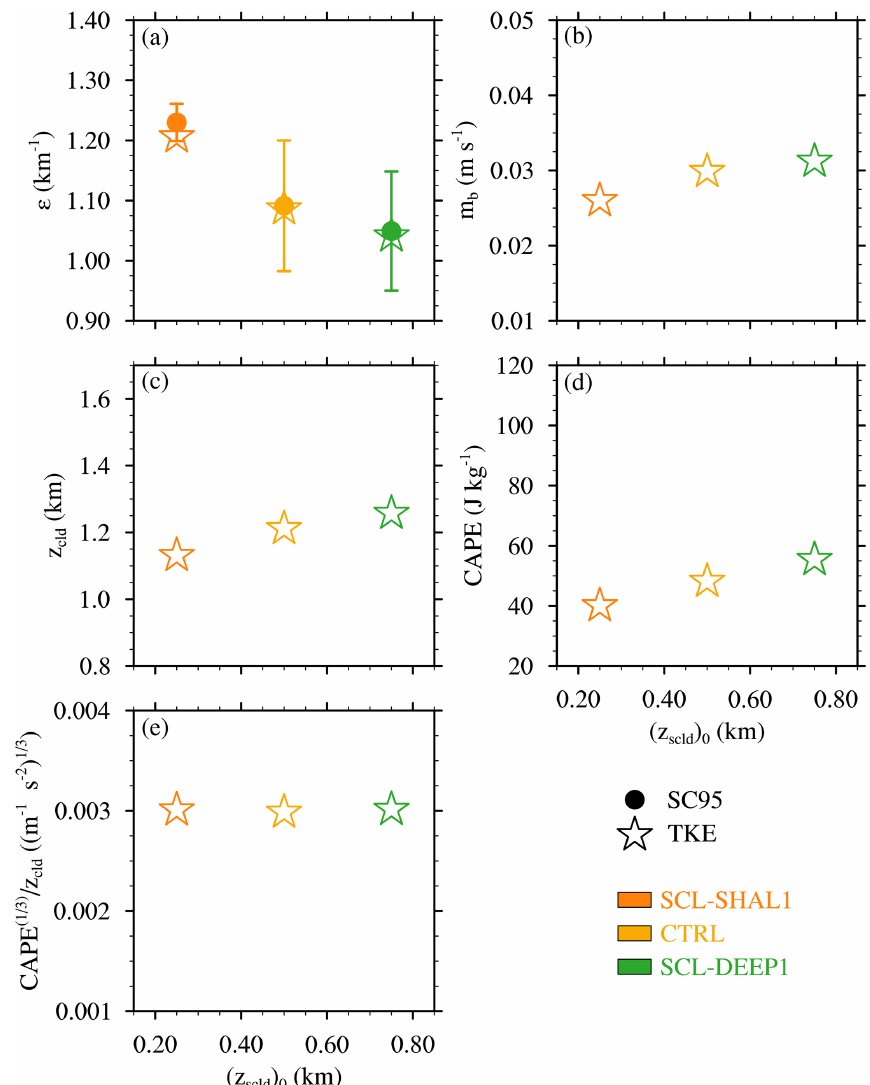
Figure 9. Same as Fig. 7 but for subcloud-layer depth